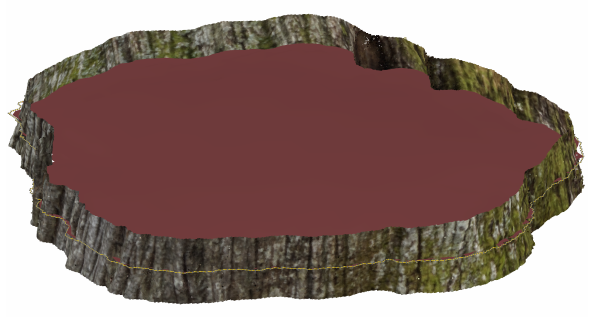
Figure 1. Mesh of the DBH section from the RGB reflex point cloud. The red color represents the surface created by the section contour (yellow line).